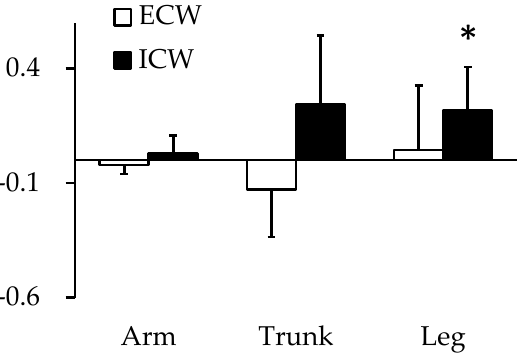
Figure 3. Change in water distribution during carbohydrate loading assessed using segmental BIA. Values are expressed as mean ± standard deviation of delta value (post-loaded value − pre-loaded value). ECW, extracellular water; ICW, intracellular water. * Significant ( p < 0.05) difference between pre-loaded value and post-loaded value.